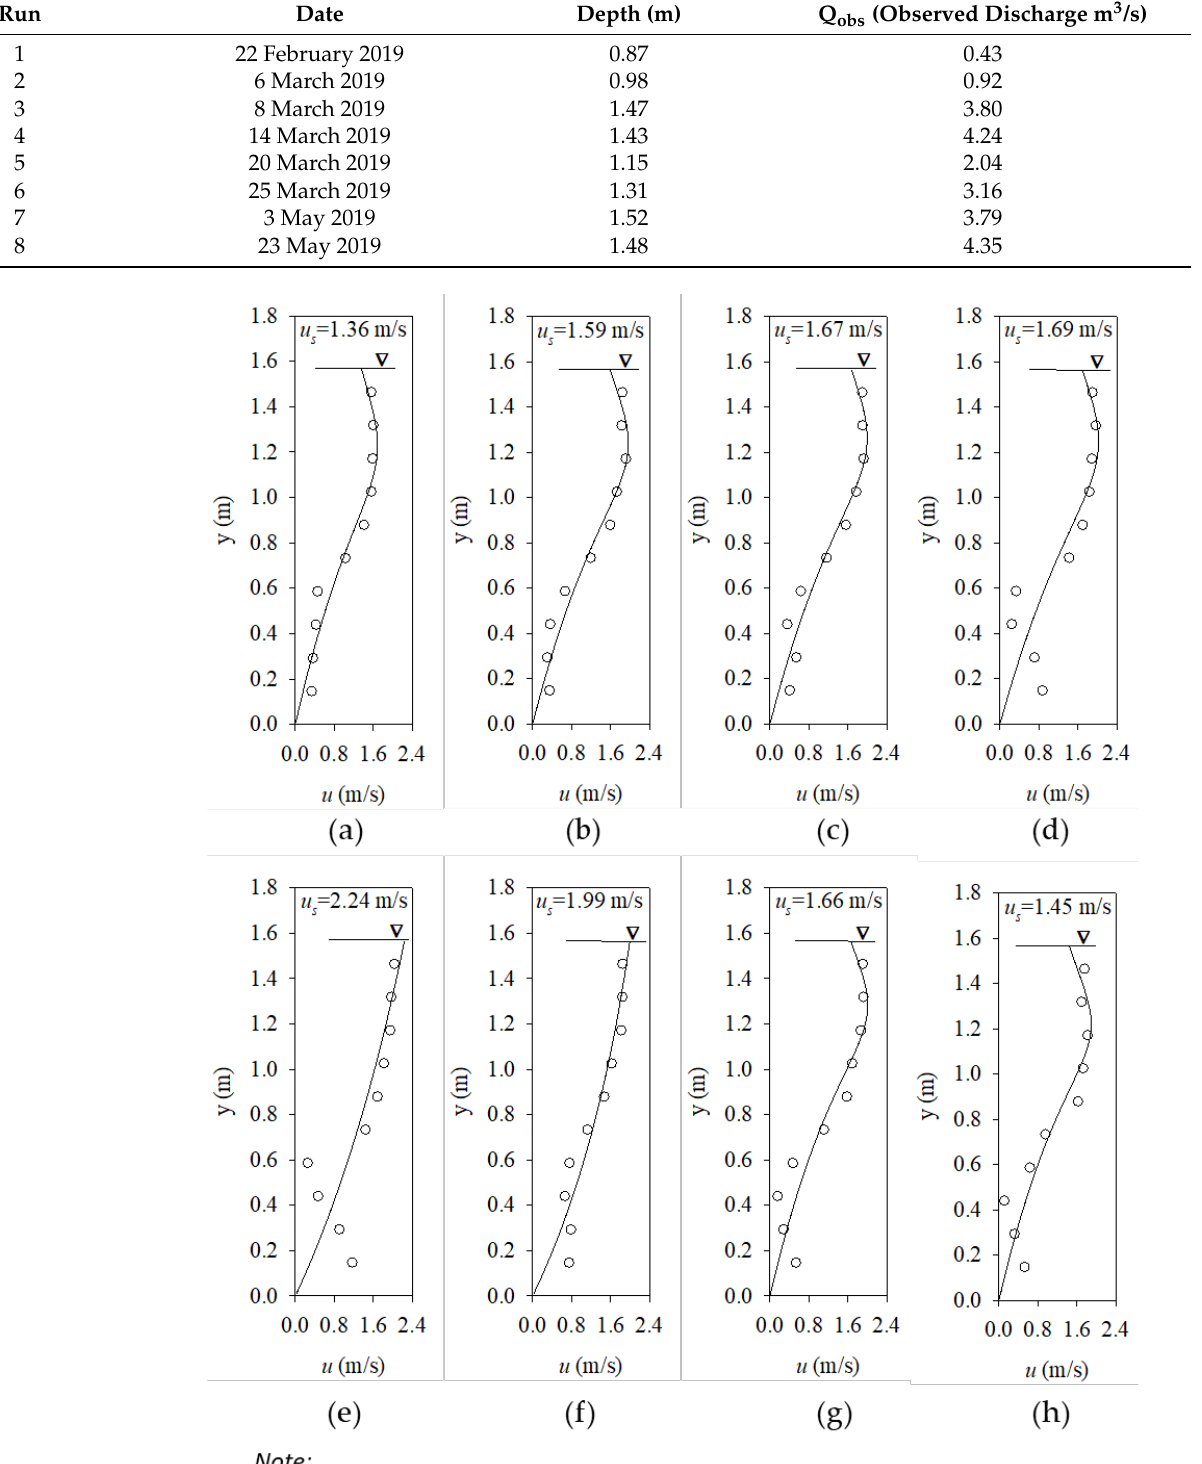
Table 1. Discharge measurement of the Longen Channel.